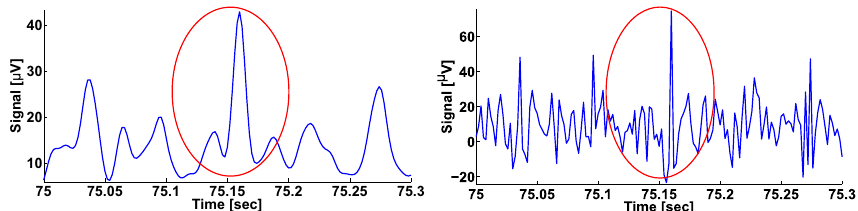
Figure 4. On the left is the envelope of the EMG signal considered in Figure 3. The abscissa axis indicates the time; the ordinate axis indicates the envelope of the signal in µ V. On the right is the source EMG signal. The abscissa axis indicates the time; the ordinate axis indicates the amplitude of the signal in µ V. The wave train is indicated by the red circle in both